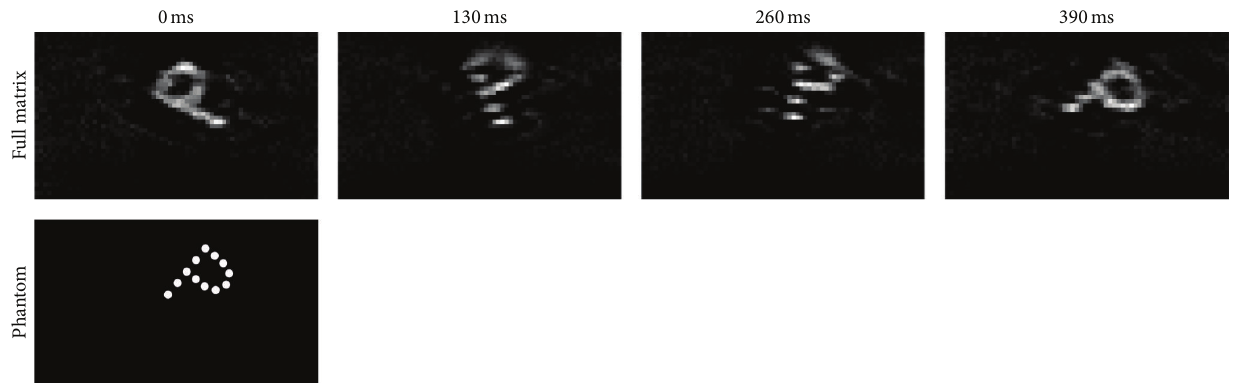
Figure 1: Reconstructed MPI data at four selected time points using the full system matrix without basis transformation. For comparison, a sketch of the used phantom is